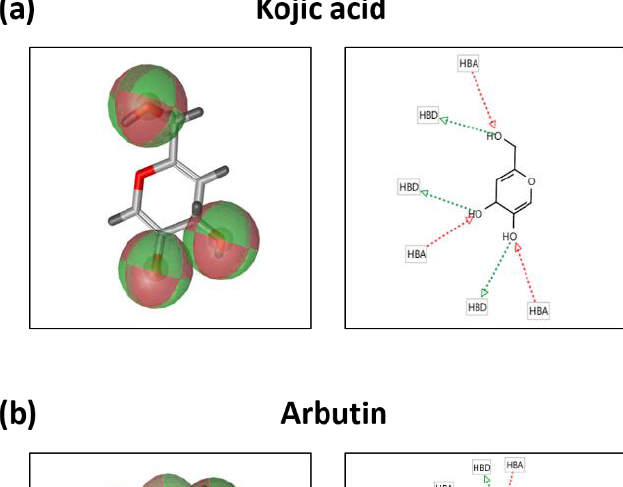
Figure 5. Binding affinity between Agaricus bisporus (PDB ID: 2Y9X) and ( a ) kojic acid (CID: 3840), ( b ) arbutin (CID: 440936), or ( c ) brassinin (CID: 3035211). AutoDock Vina software was used to pre- dict the ligand binding capacity of brassinin, which exhibits strong inhibitory activity against tyro- sinase.